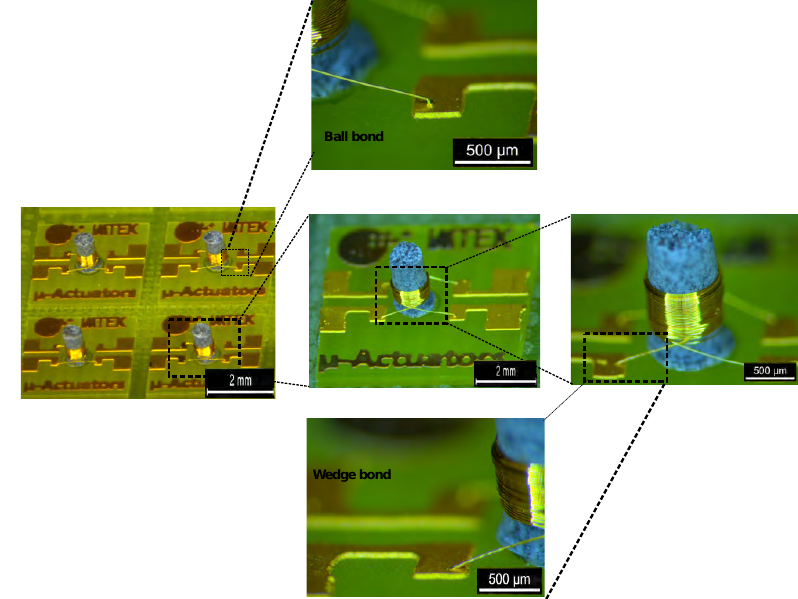
Figure 6. Microscopic images of the magnetic core transformer.